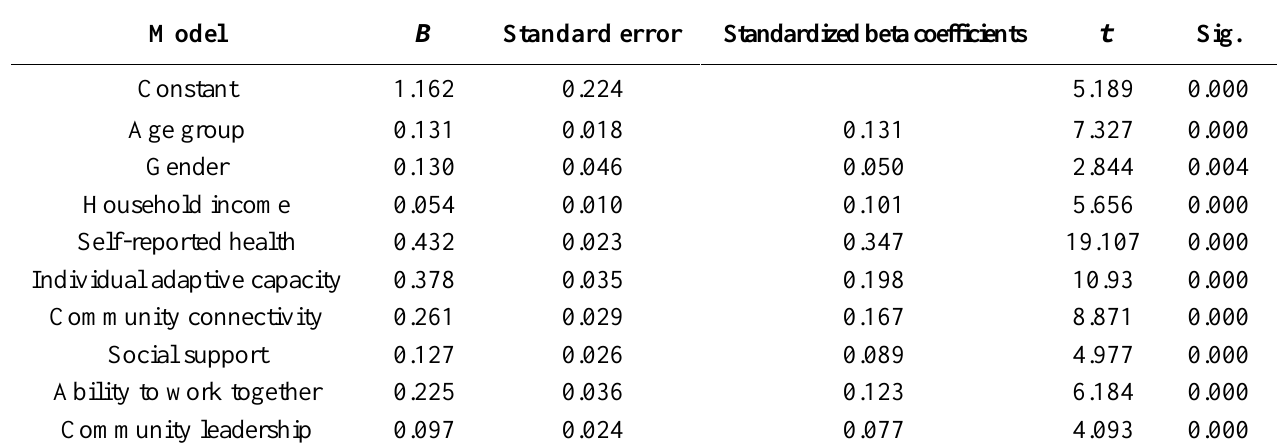
Table 6. Associations between adaptive capacity and human wellbeing (including self- reported